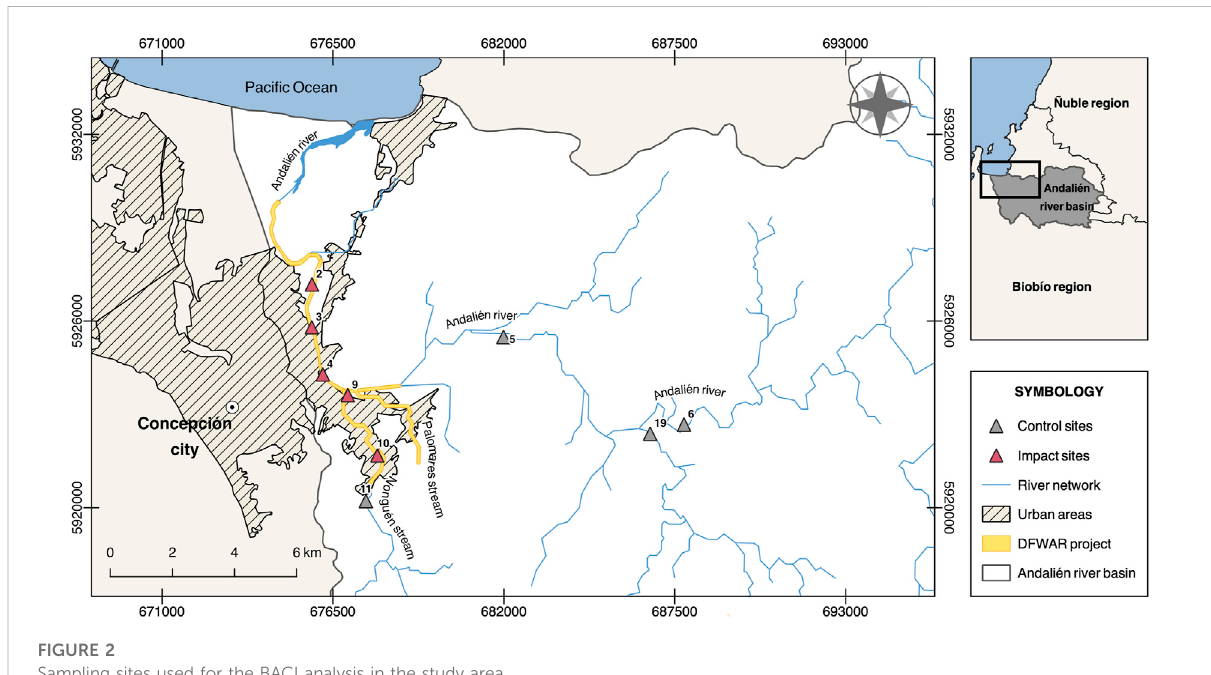
FIGURE 2 Sampling sites used for the BACI analysis in the study